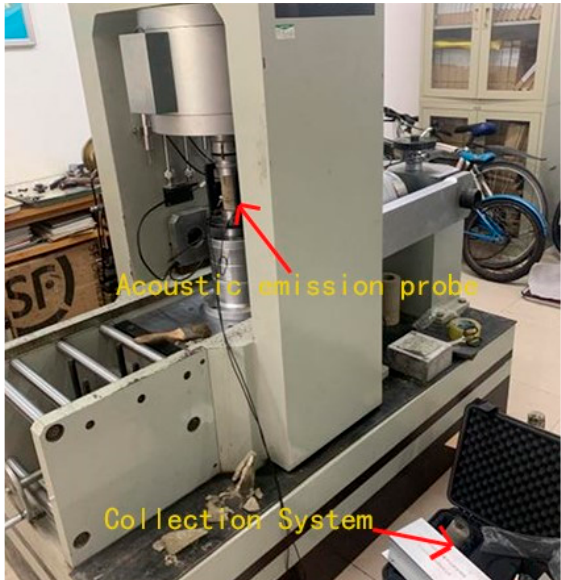
Figure 2. Testing system.